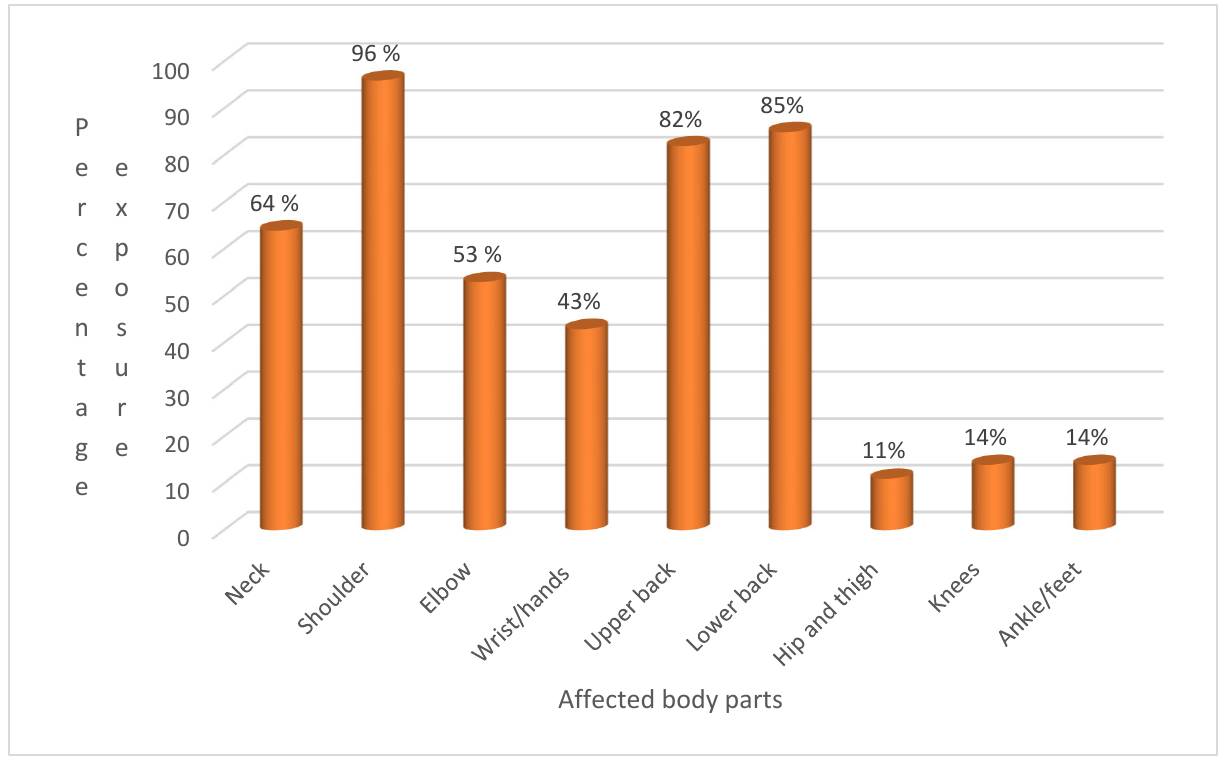
Figure 2. Self ‐ reported ergonomic injuries experienced by farmers (N = 480). Source: Surveyed Data Analysis, 2018.